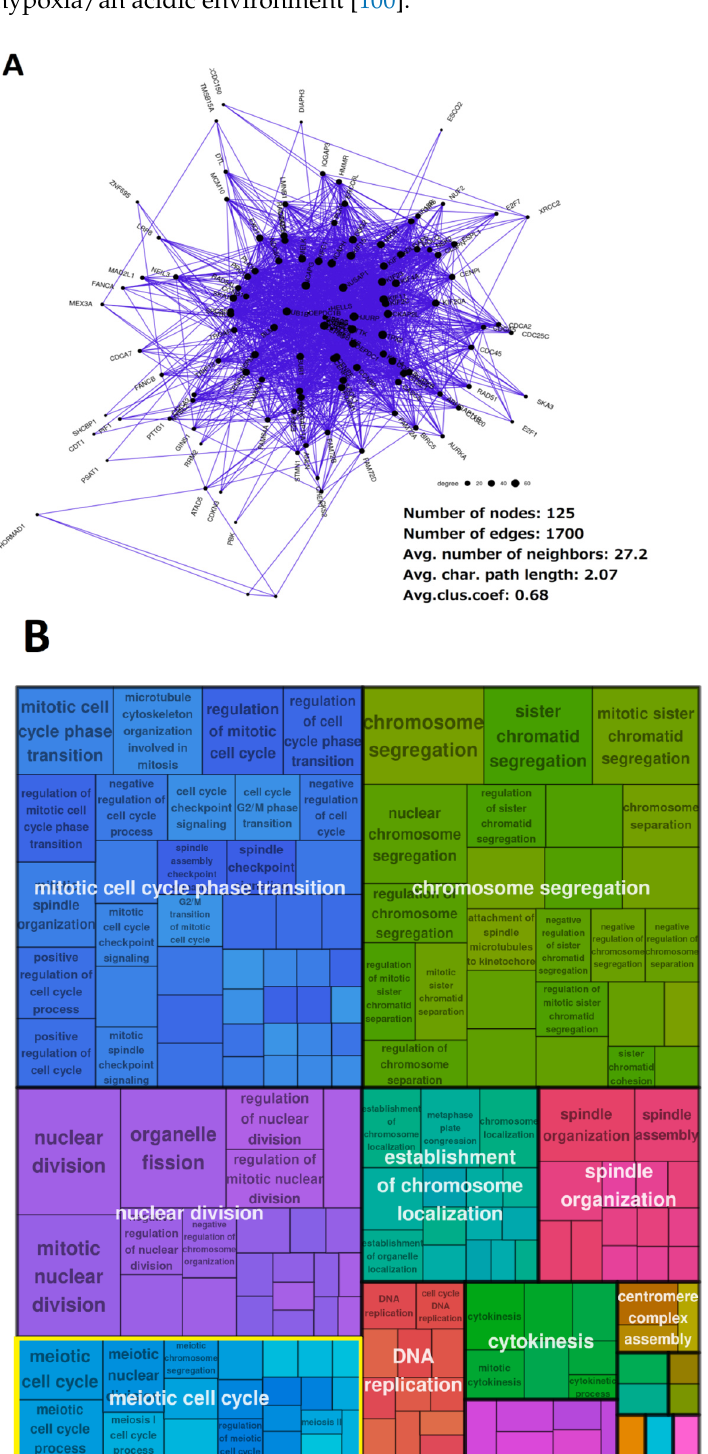
Figure 6. The cooperation of the ploidy-upregulated genes in TCGA-BRCA: ( A ) The giant component of the coexpression network of ploidy-upregulated genes. ( B ) A tree map plot of GO biological process modules enriched in this network. Modules related to meiosis are highlighted (yellow).